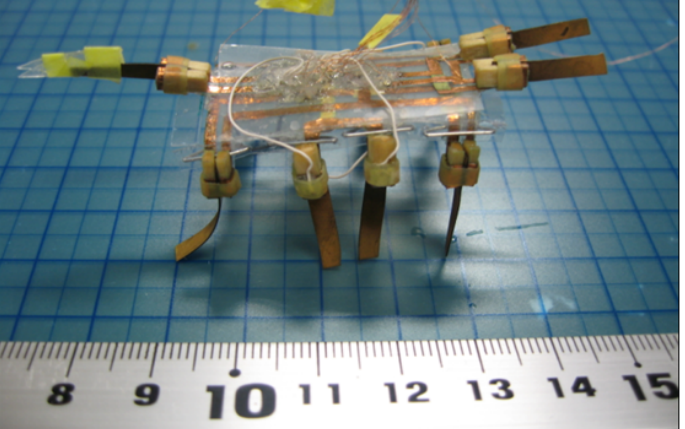
Figure 3. The prototype of IPMC microrobot (source: